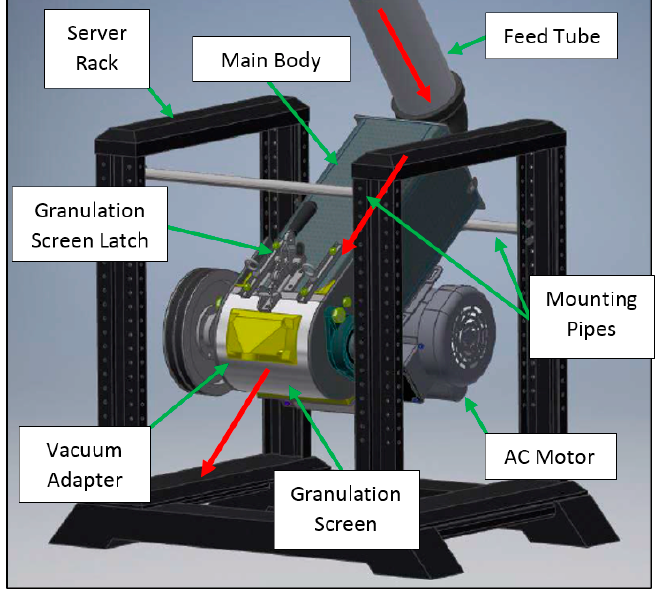
Figure 5. Overall design setup of the open source waste plastic granulator with primary parts labeled with green arrows. Red arrows indicate the path of material flow.